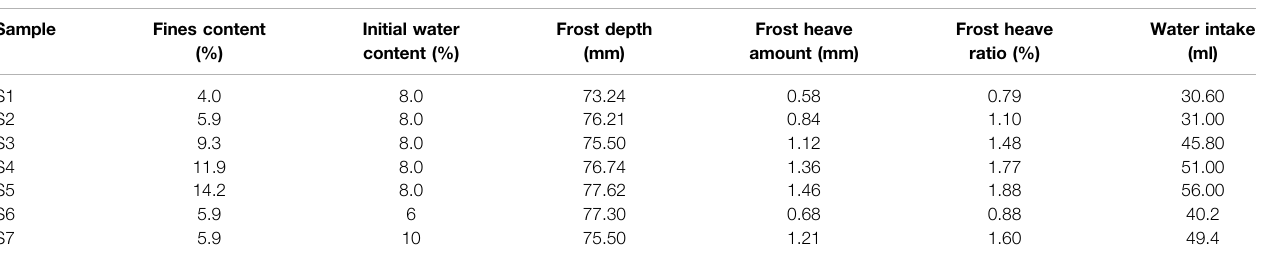
TABLE 3 | Frost heave test results for samples S1 − S7 after freezing for 144 h.